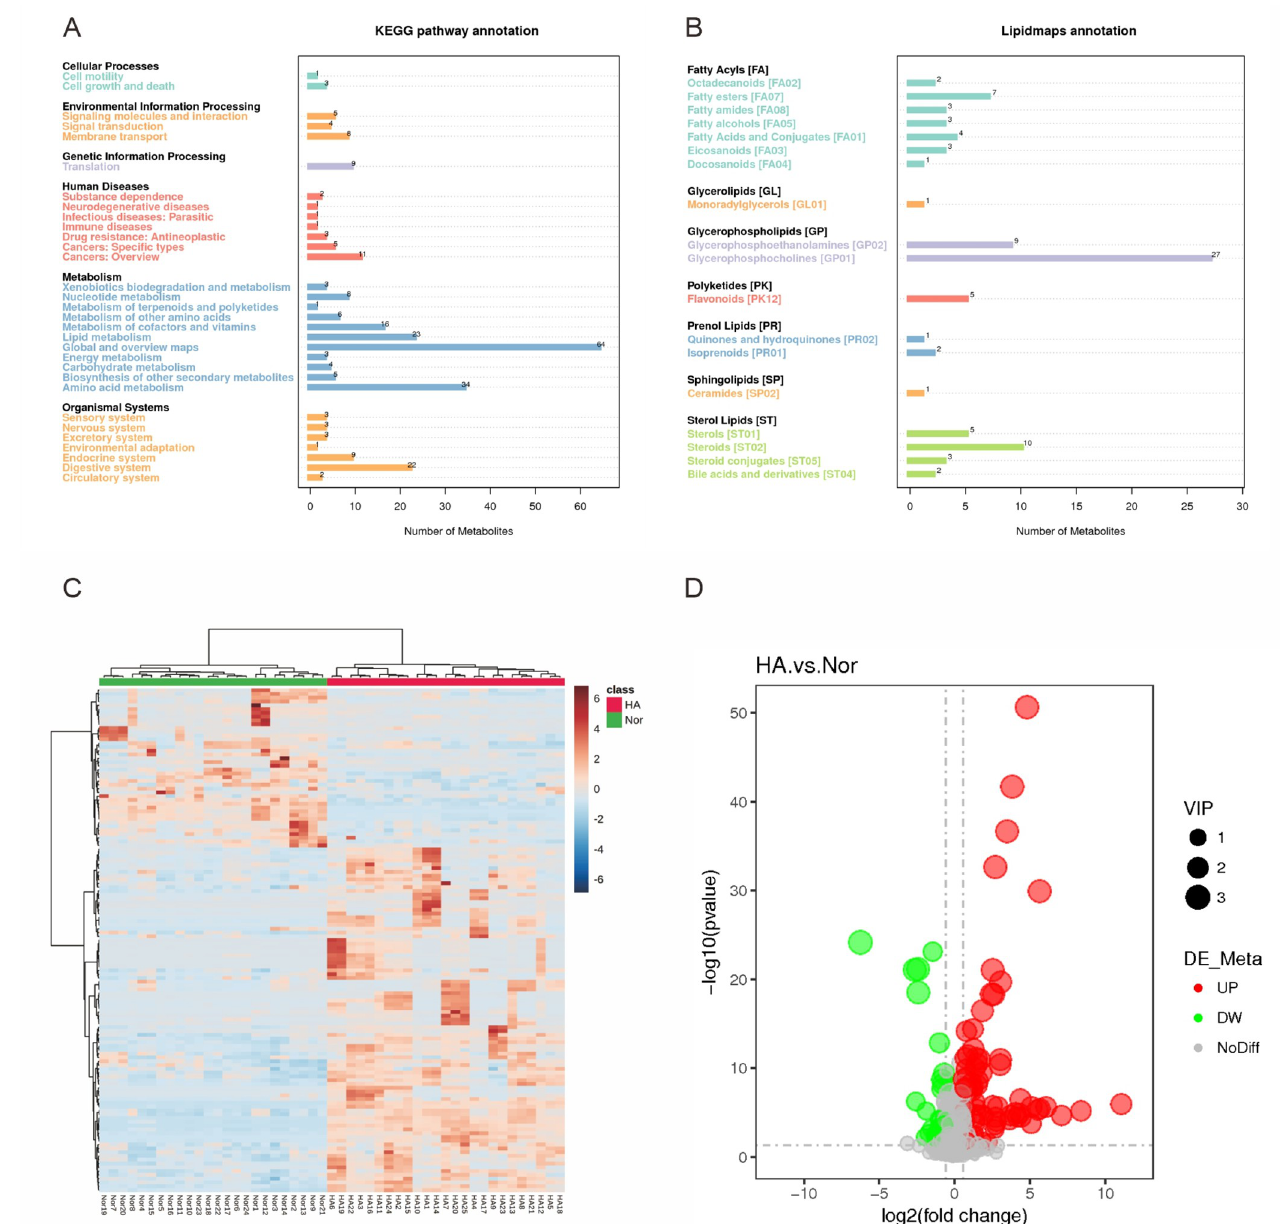
Fig 3. Annotation and screening of metabolites. Annotation of metabolite pathway results based on KEGG (A) and Lipidmaps (B). Heat map of the differential metabolites between Nor and HA groups (C). The volcano plot of the metabolites, red points represent up-regulated metabolites and green point represented down-regulated metabolites